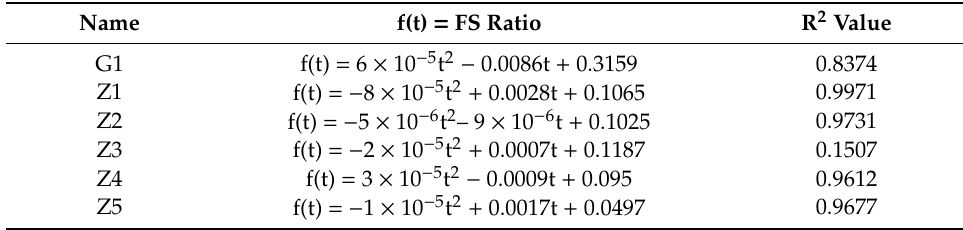
Figure 10. Comparison of flexural strength / compressive strength ratio in time function. Table 12. Comparison of flexural strength (FS) ratio in time function equations and coe ffi cient of